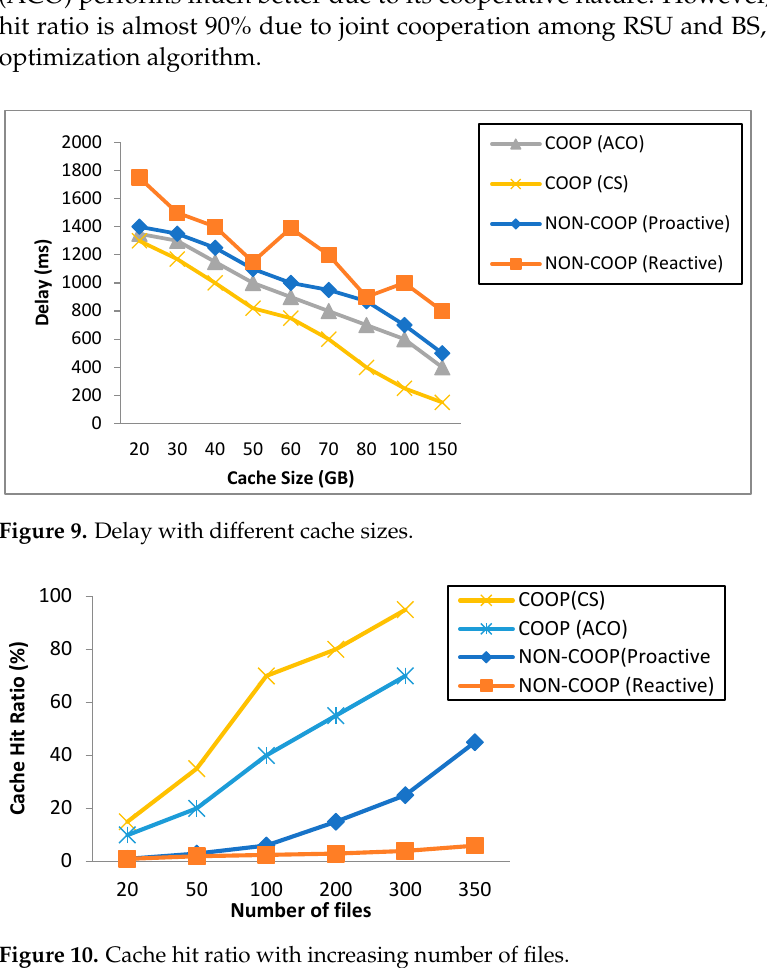
Figure 8. Delivery cost with different cache sizes.